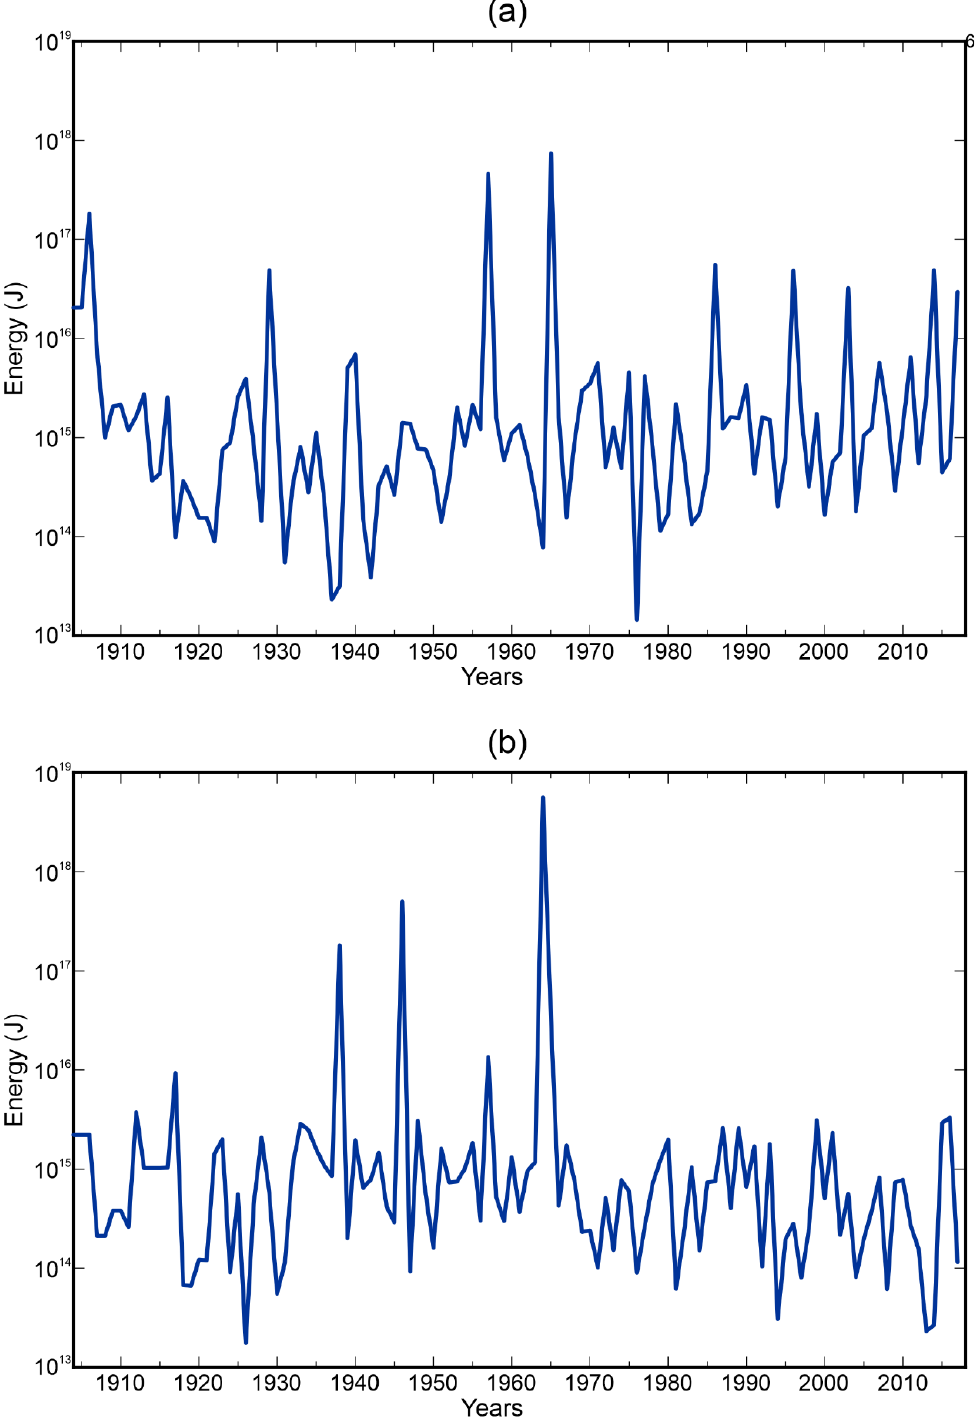
Figure 2. Time distribution of seismic energy release for ( a ) the western part and ( b ) the eastern part of the subduction zone.